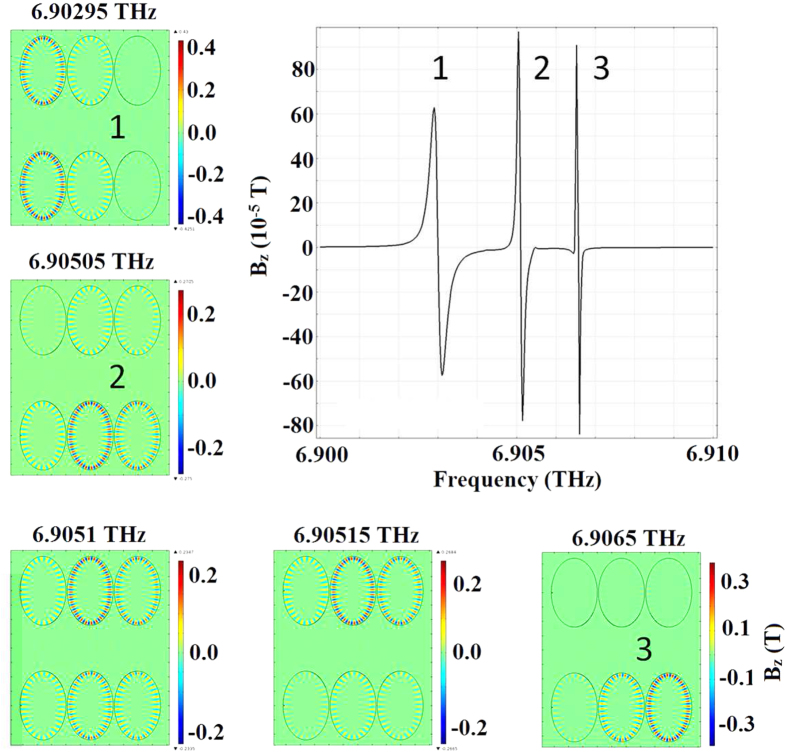
Microlaser switching over a range of frequencies close to
6.9 THz in a transverse electric field.The colour bar indicates the strength of the resulting magnetic flux density.
The magnetic field Bz is a function of frequency
and is measured at positions 1–3. The complex refractive indices
of the disks are taken to be
NTiO2 ≈ 2.025 + 0.500i
and
NAg = 6.168 + 44.787i
at this frequency.